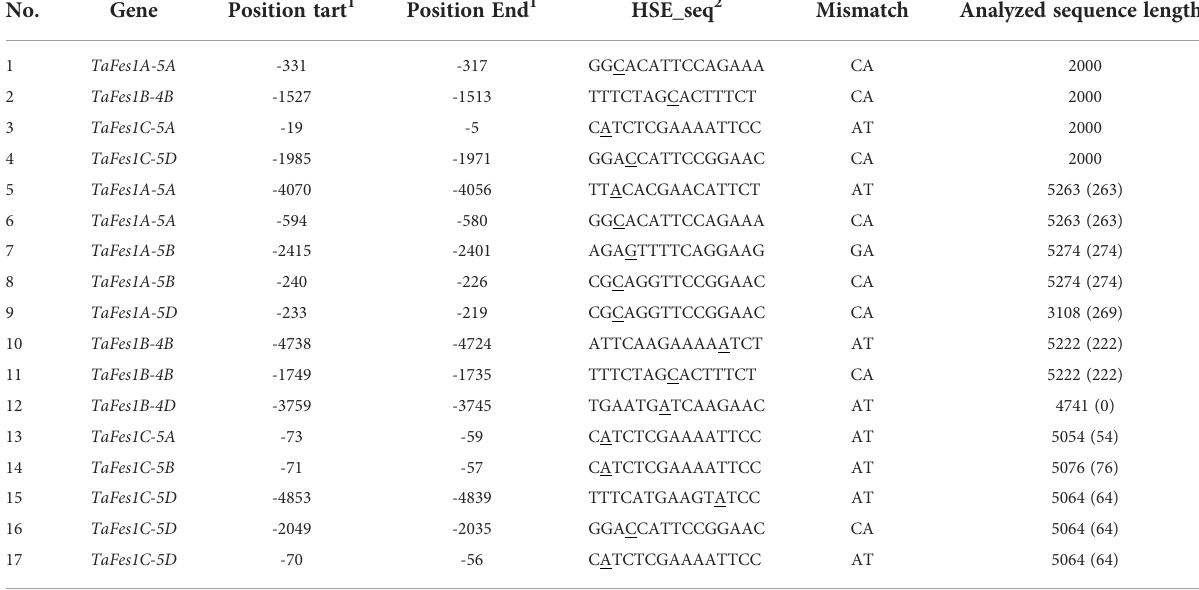
TaFes1Bs and TaFes1Cs , all three TaFes1As were more highly and constitutively expressed across different tissues in both “ Azhurnaya ” and “ Chinese Spring ” , the three TaFes1Bs were likely preferred to be transcribed more in grain, and the three TaFes1Cs were constitutively but relatively lowly expressed (Figure 5A; Supplementary Figure 2). In wheat thermotolerant variety “ TAM107 ” (Figure 5B), all TaFes1s were transcribed more in heat, and combined stress conditions, three TaFes1As were sharply responded to short time stress (H_1h and DH_1h), while three TaFes1Bs were stably highly expressed (H_1h, H_6h, DH_1h, and DH_1h). In wheat thermosensitive variety “ Chinese Spring ” , besides the fact that TaFes1C-5B were relatively lowly